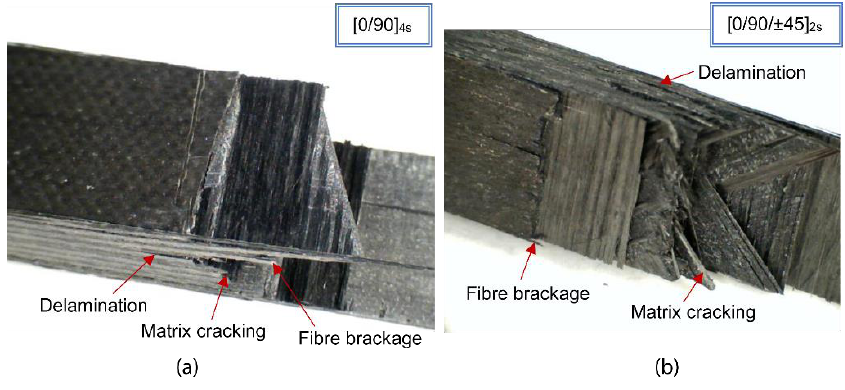
Figure 6. Failure modes observed in non-aged (a) [0/90] 4s and (b) [0/90/±45] 2s laminates ( E impact = 32.46 J).